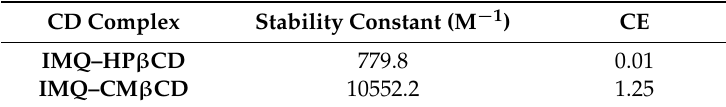
Table 1. Stability constant (M − 1 ) and complexation efficiency (CE) of imiquimod (IMQ) inclusion complexes. Please add the full name.